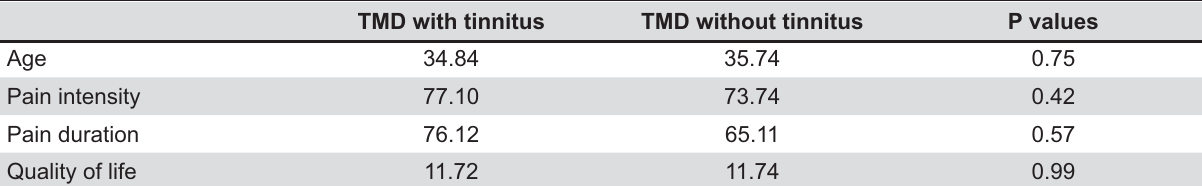
TMD= temporomandibular